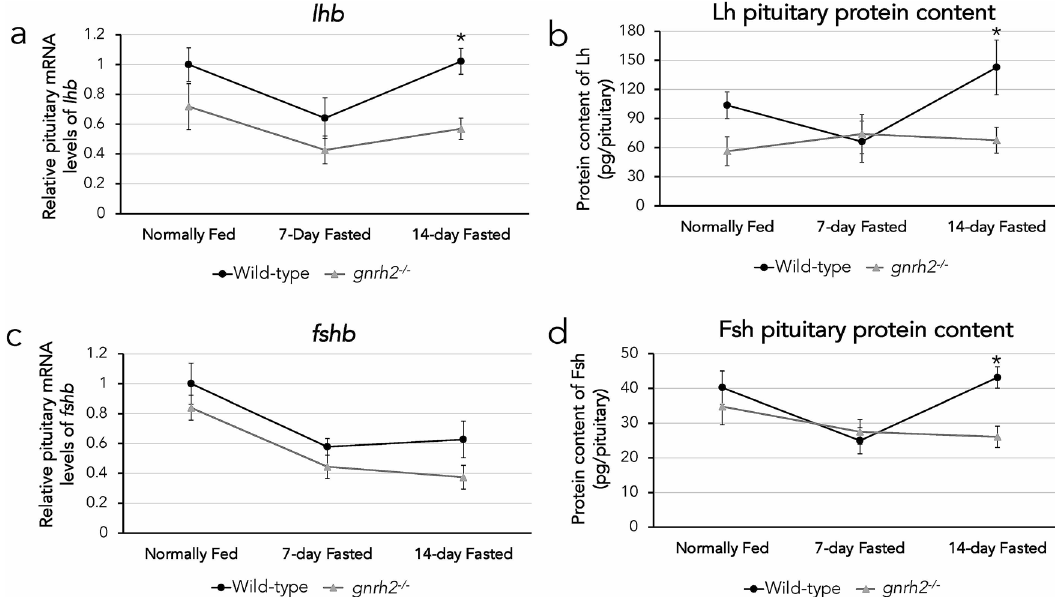
Figure 4. Expression differences of Lh and Fsh in wild-type and gnrh2 −/− zebrafish. Relative mRNA levels of lhb (a) and fshb (c) from pituitaries of wild-type and gnrh2 −/− ∆ zebrafish undergoing normally fed, 7-day fasting, or 14-day fasting conditions. Protein content of Lh (b) and Fsh (d) from pituitaries of wild-type and ● gnrh2 −/− ∆ zebrafish undergoing normally fed, 7-day fasting, or 14-day fasting conditions. All data expressed as ● means ± S.E.M, n = 8 pituitaries per group, *P <